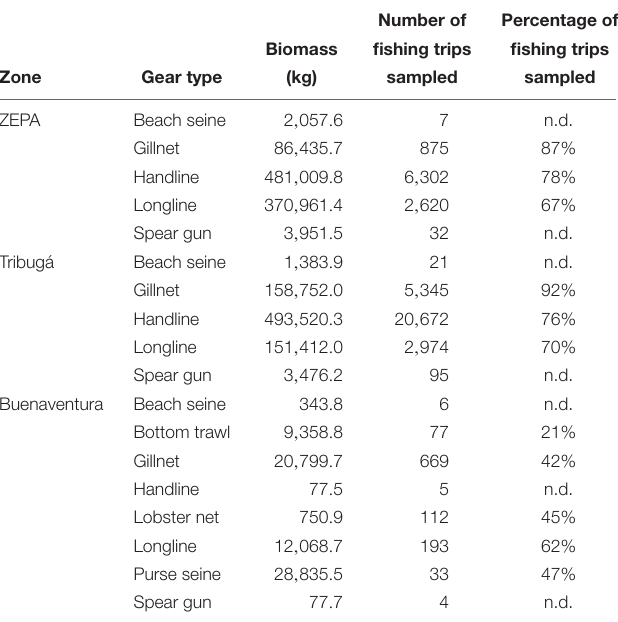
TABLE 3 | Total biomass in the nominal catch (i.e., live weight converted from landed weight, as described in section “Materials and Methods”) of SSF, number of fishing trips sampled and estimated percentage of trips sampled per gear type at landing sites of the three coastal zones of the Colombian Pacific included in the present study (n.d., no data available on total number of